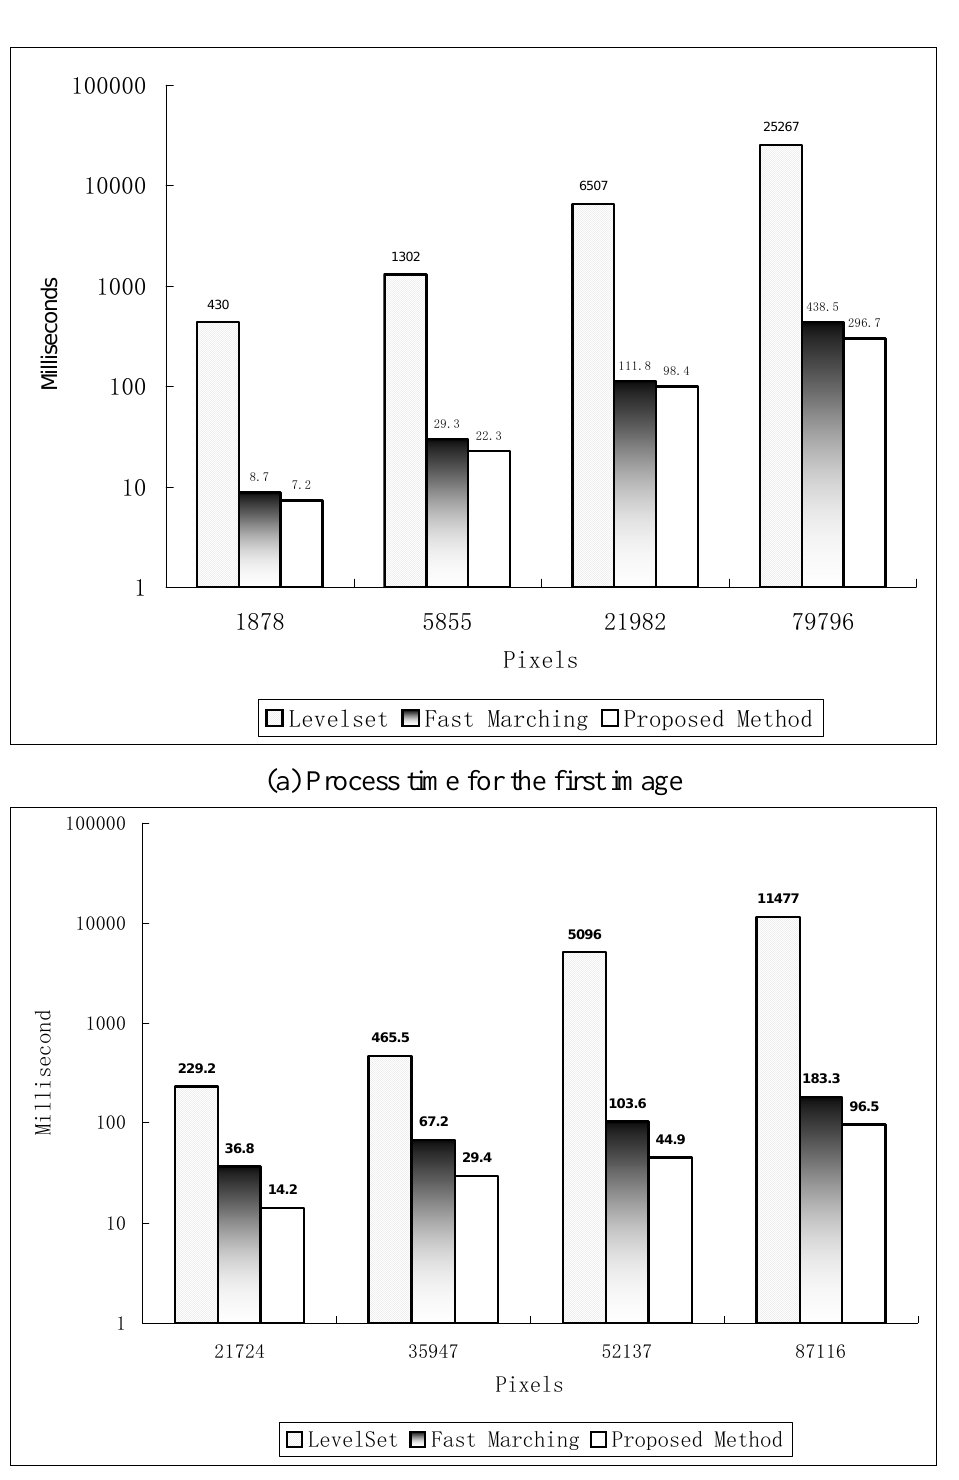
Figure 7. Comparison of the proposed method with the ordinary level set and fast marching methods